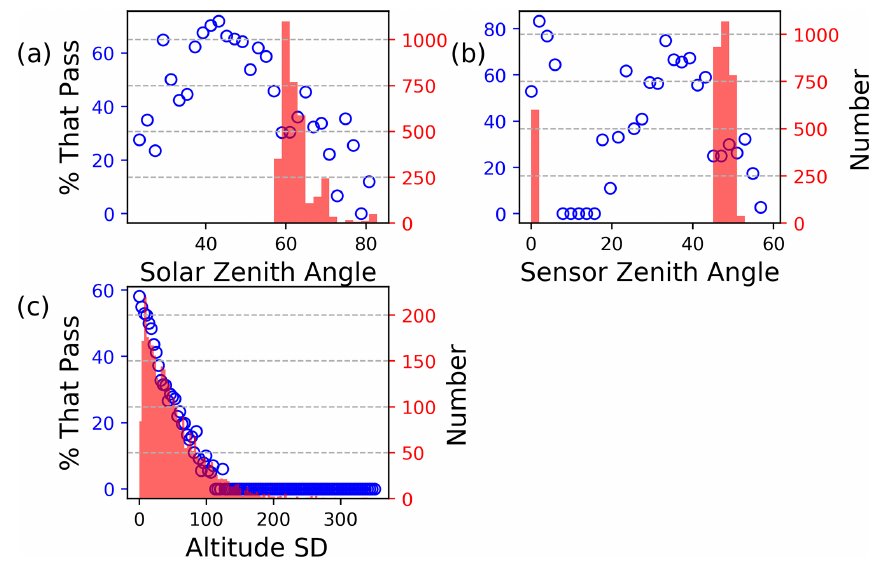
Figure 4. The percentage of data that passes the NN filter (blue dots) for a given solar zenith angle (a) , sensor zenith angle (b) and altitude standard deviation (stddev) (c) . The bars are the histograms of the OCO-2 soundings coincident with the Eureka TCCON data.